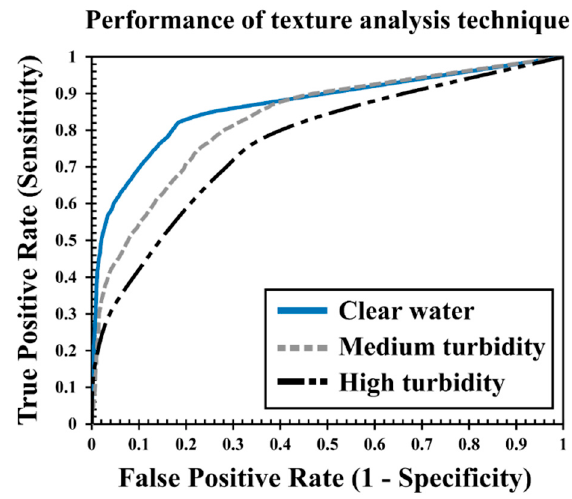
Figure 17. ROC curves for a texture analysis-based image processing technique applied under three turbidity conditions for detecting corrosion.